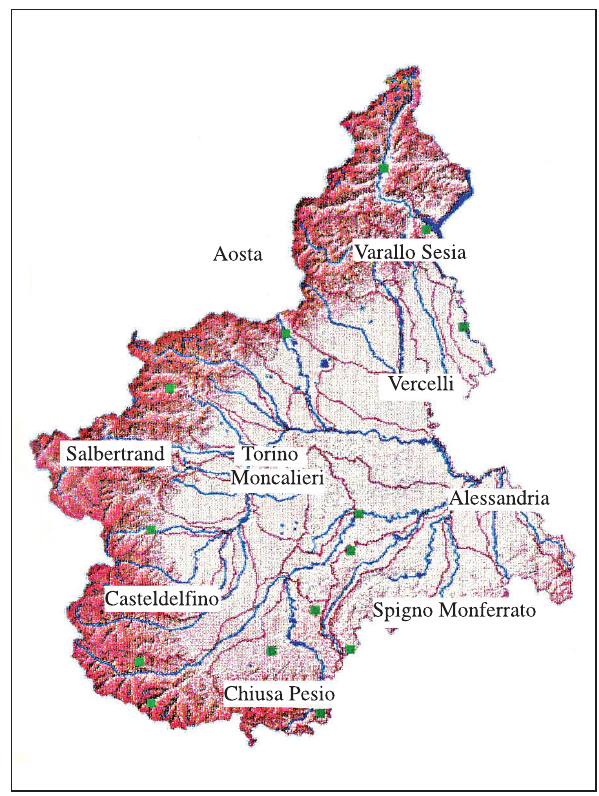
Fig. 1. Chart of the stations of «Uffi cio Idrografi co» chosen to create our rainfall